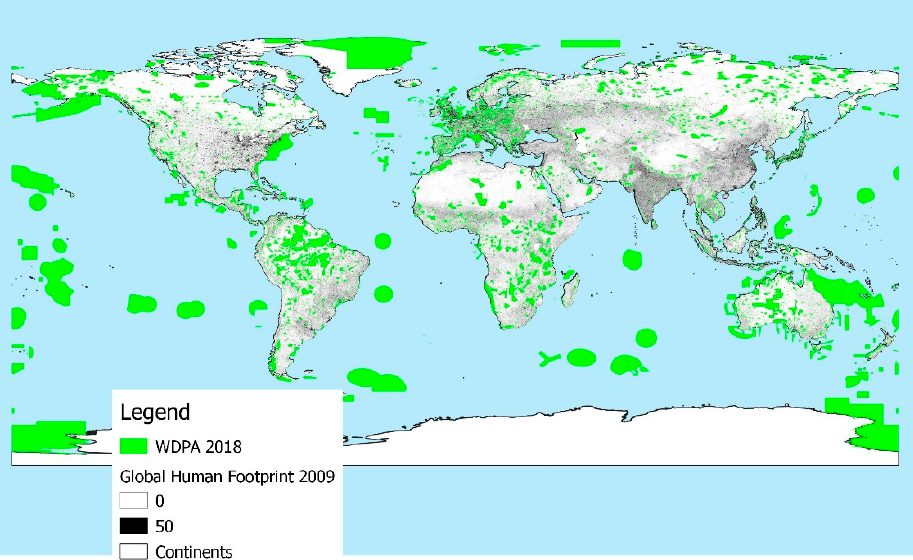
Figure 1. Largest protected areas of the world across marine and terrestrial ecosystems in relation to areas of human land use transformation, the Global Human Footprint. WDPA 2014, Accessed from Protected Planet October 2018. Global terrestrial Human Footprint maps for 2009 from Dryad Digital Repository; HF values stretched from 0 (min) to 50 (max). https://doi.org/10.5061/dryad.052q5.2 (Venter et al. 2016) [9].